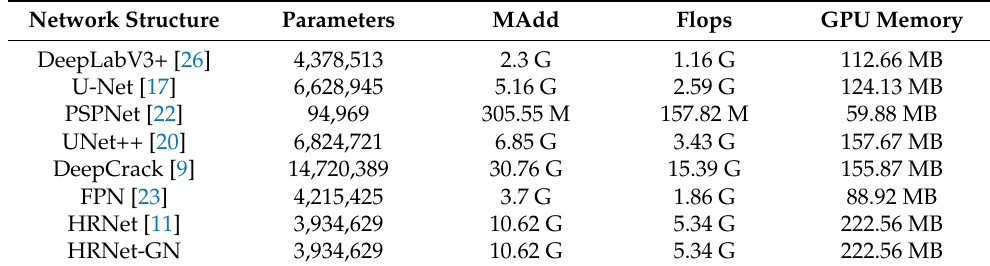
Table 2. Information about number of parameters, number of calculations, and GPU memory usage levels of the tested